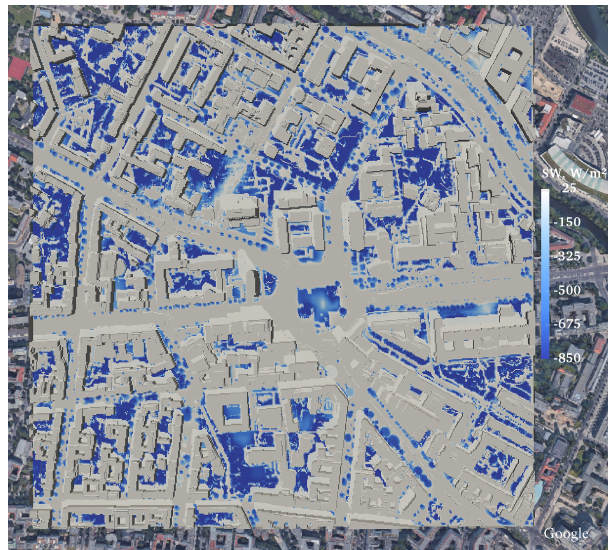
Figure 18. Changes in the received SW radiation flux for the realis- tic urban configuration at 10:00LST due to including the vegetation interaction with the SW radiative transfer (RTM_03). The copyright for the underlying satellite image is held by © GeoBasis-DE/BKG 2009, Google